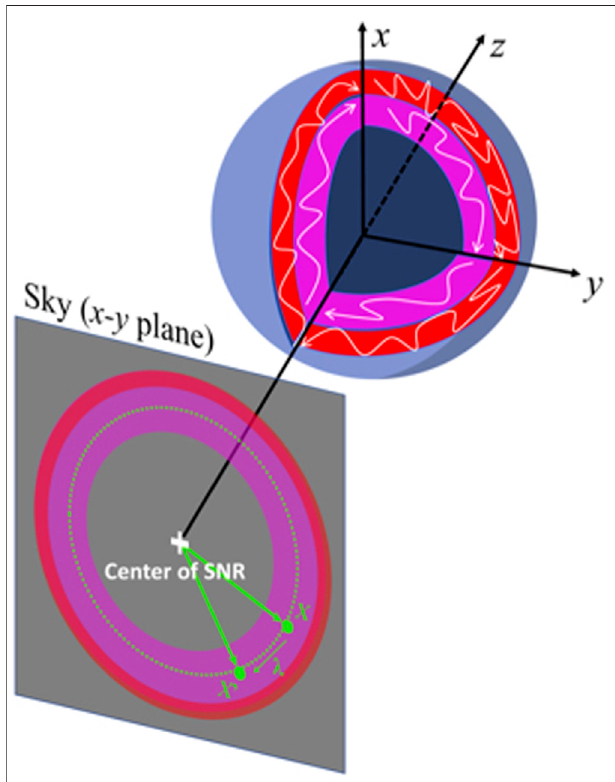
FIGURE 5 | Schematic of SNR shell and projected image. The blue spherical shell with partial cross-sections shows the SNR shell. The line of sight is along the z -axis, and the x – y plane corresponds to the projected sky. The white lines schematically indicate turbulent magnetic- fi elds. The synchrotron radiations from turbulent media are projected onto the sky (red andmagentatoruses).ThewhitecrossindicatesthecenteroftheSNRimage. Ifweanalyzetheintensitycorrelationbetweenthetwopositions X and X ′ = X + λ ontheconcentriccircle(thegreendots),thelineofsightextent L ( X )becomes constant and the correlation functions is not affected by the structure of the SNR shell. Reproduced form Shimoda et al. (2018a, Monthly Notices of the Royal Astronomical Society,480,2200).